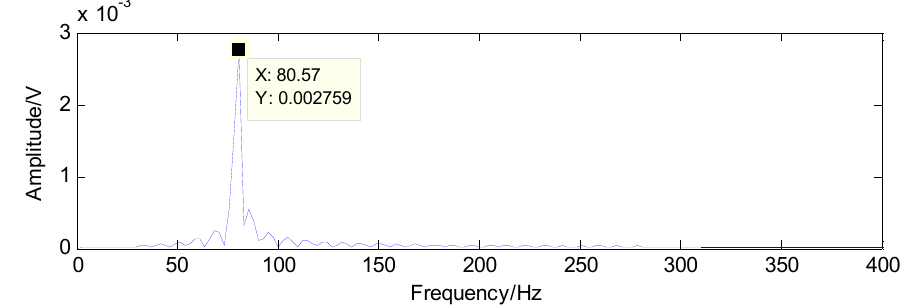
Figure 26. Second harmonic of the detected fault characteristic frequency through matching pursuit.